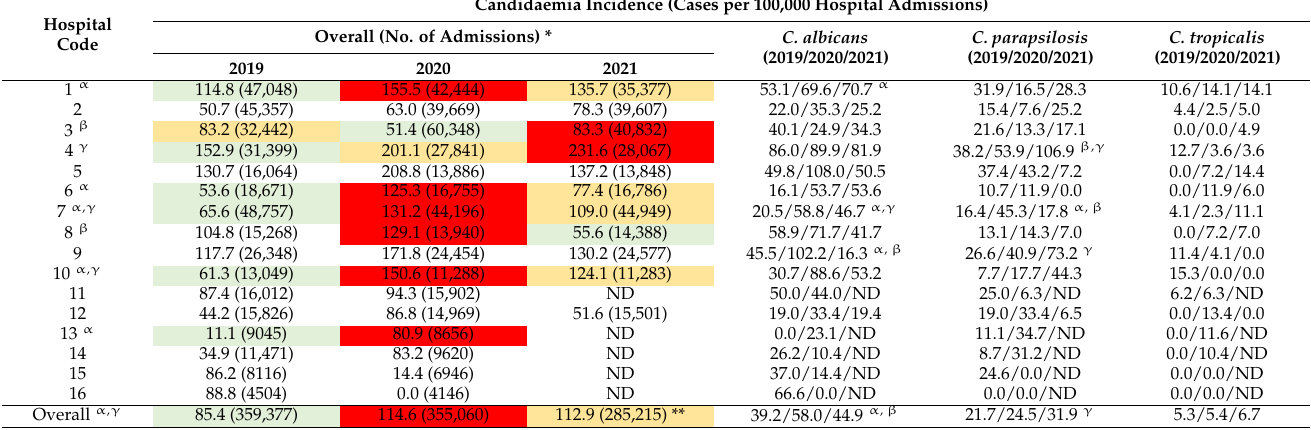
Table 4. Number of admissions and incidence of candidaemia, overall and per species, per participant hospitals, and overall, during 2019, 2020, and